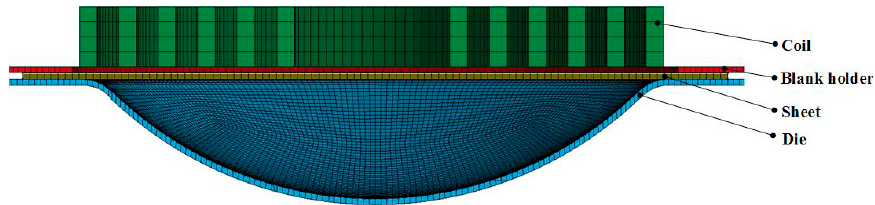
Figure 9. Half of finite element model for high-speed electromagnetic impaction with a hemispherical die.